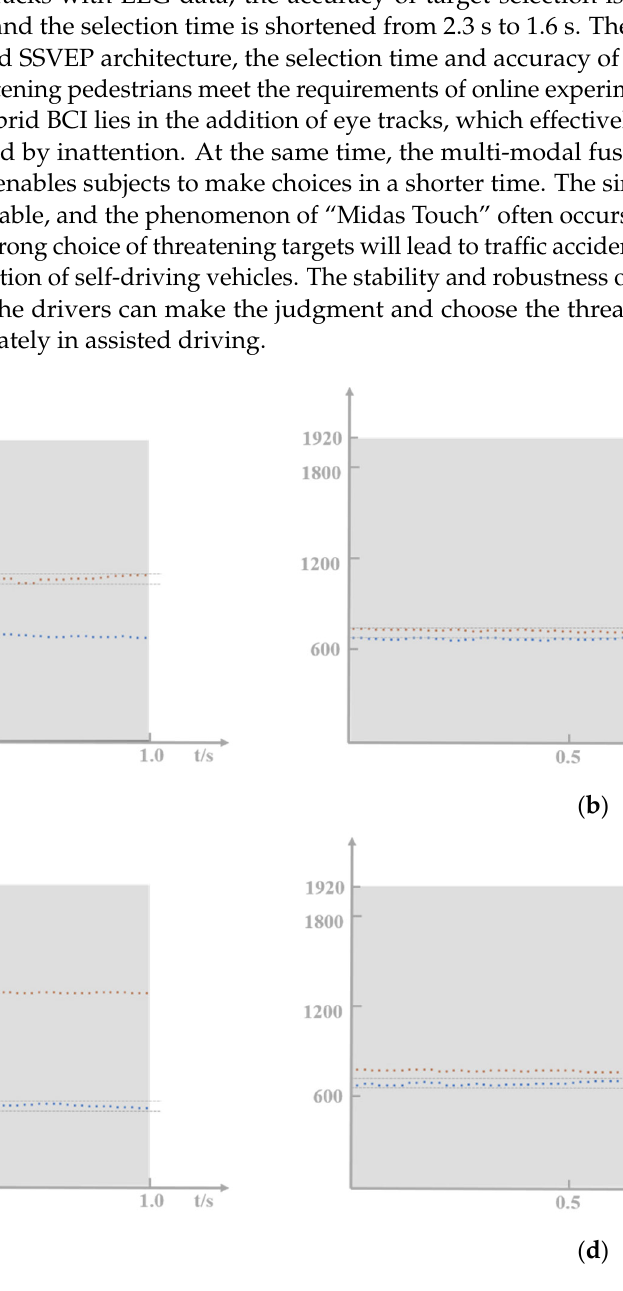
Figure 6. The change of eye movements during saccade in the direction of arrows. ( a ) Top ‐ to ‐ bottom saccade; ( b ) Bottom ‐ to ‐ top saccade; ( c ) Right ‐ to ‐ left scanning; ( d ) Left ‐ to ‐ right saccade. The blue line represents the change in the x direction and the orange line represents the change in the y direction. The distance between the two gray lines is 60 pixels.